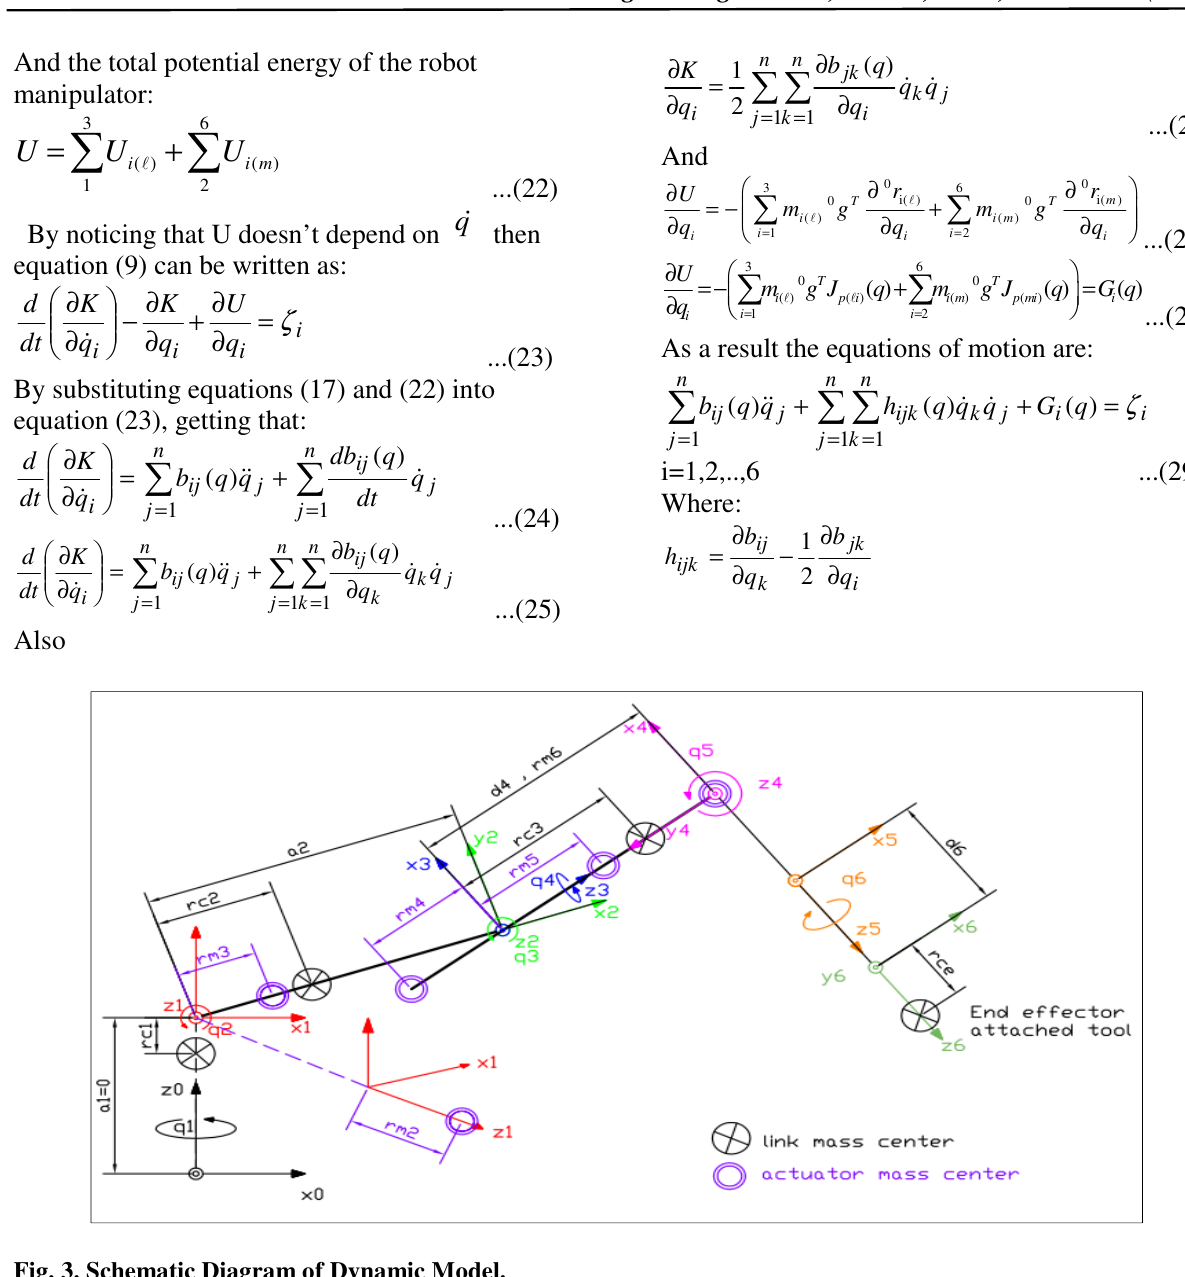
Fig. 3. Schematic Diagram of Dynamic